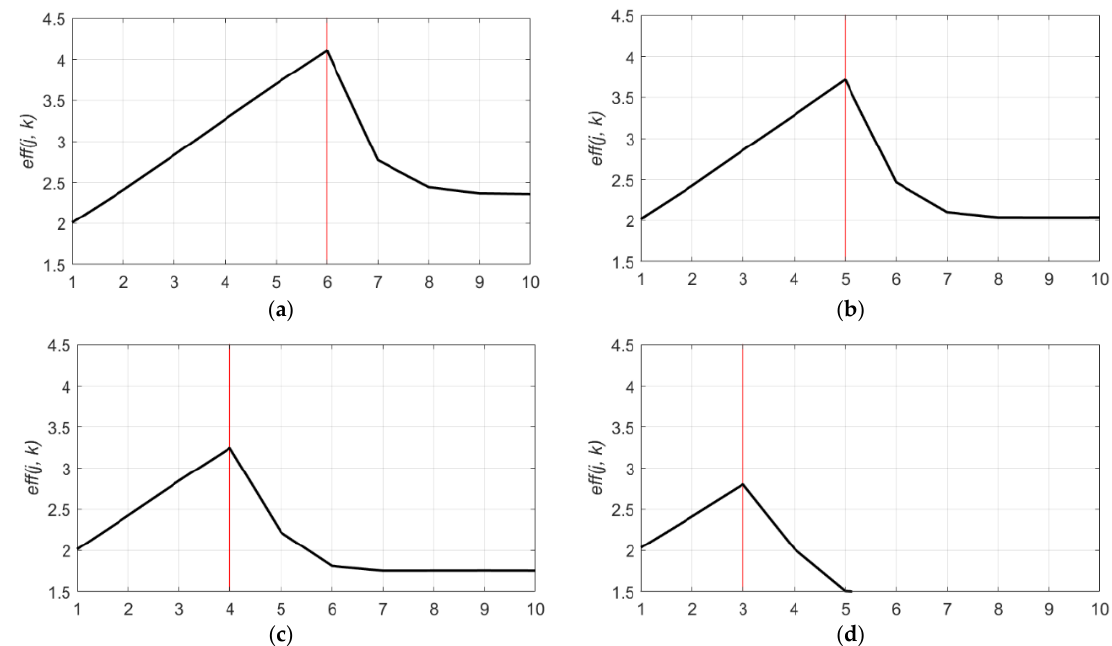
Figure 1. 𝑒𝑓𝑓(𝑗,𝑘) values of 10 decomposition levels (1 to 10) for db9. ( a ) 𝑒𝑓𝑓(𝑗,𝑘) values for a sampling frequency of Figure 10. ef f ( j , k ) values of 10 decomposition levels (1 to 10) for db9. ( a ) ef f ( j , k ) values for a sampling frequency of 500 Hz; ( b ) 𝑒𝑓𝑓(𝑗,𝑘) value for a sampling frequency of 250 Hz; ( c ) 𝑒𝑓𝑓(𝑗,𝑘) values for a sampling frequency of 125 Hz; 500 Hz; ( b ) ef f ( j , k ) value for a sampling frequency of 250 Hz; ( c ) ef f ( j , k ) values for a sampling frequency of 125 Hz; and and ( d ) 𝑒𝑓𝑓(𝑗,𝑘) values for a sampling frequency of 62 Hz. ( d ) ef f ( j , k ) values for a sampling frequency of 62